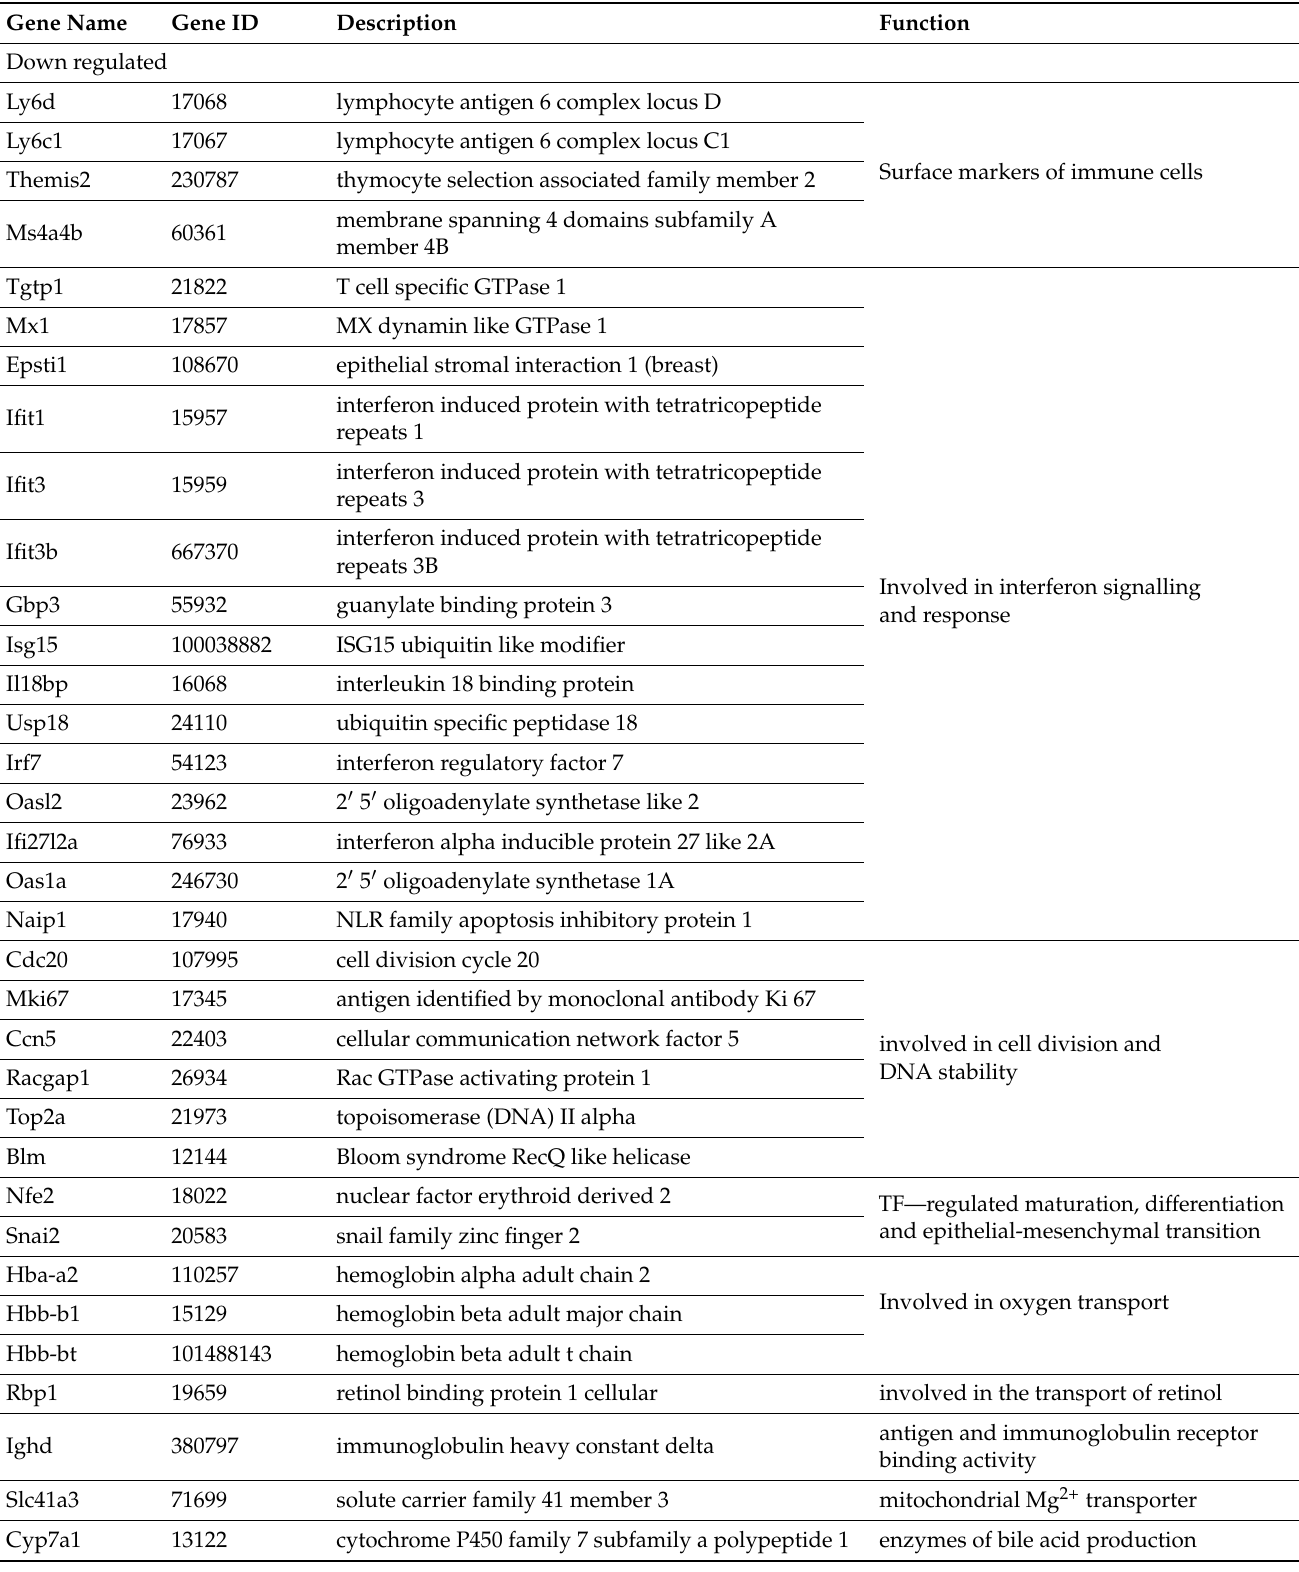
Table 3. Top 52 genes differentially expressed in the liver of mice fed with